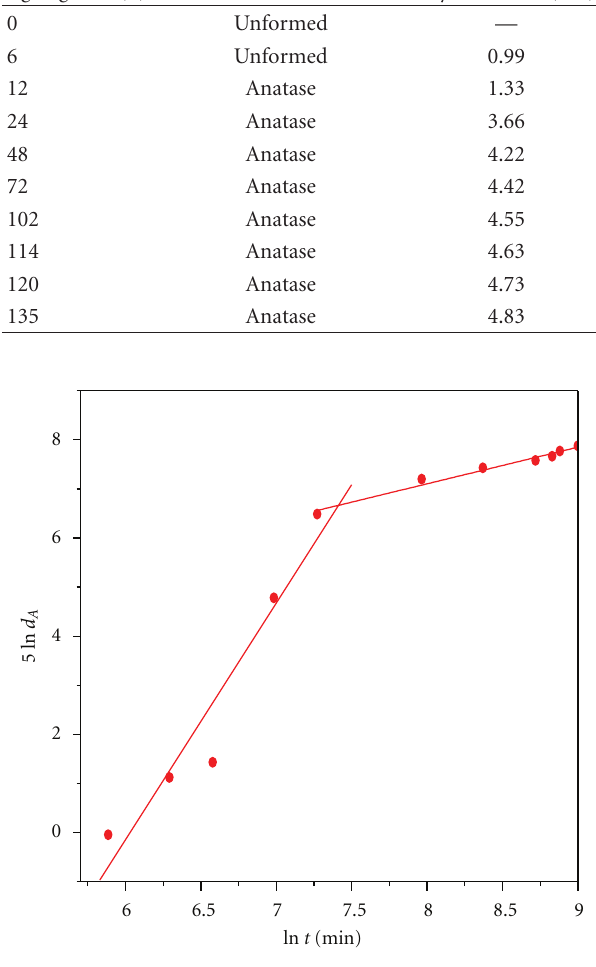
Figure 6: Fitting curves of 5ln d and ln t .